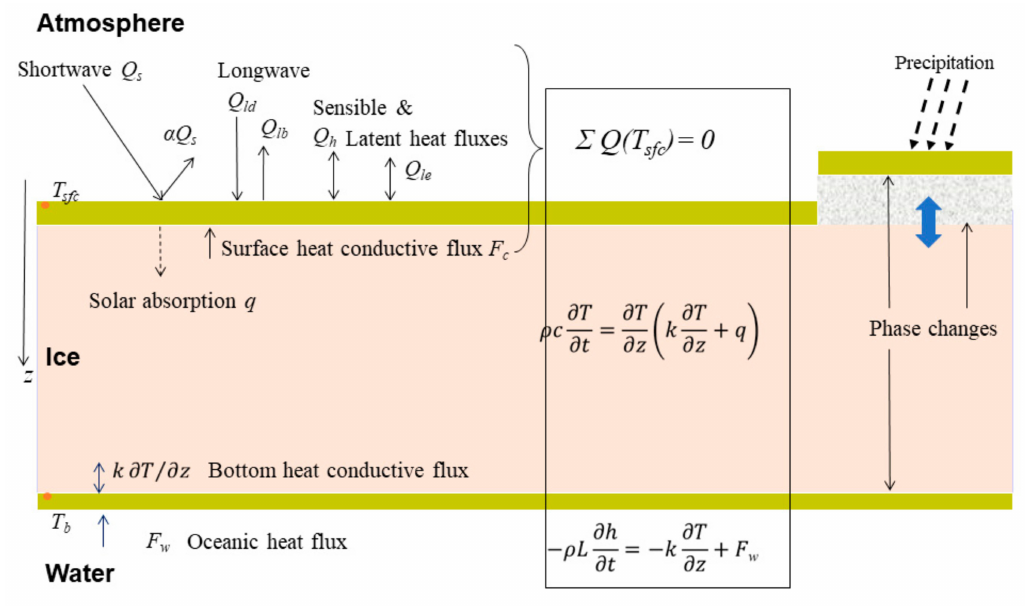
Figure 3. A schematic illustration of the HIGHTSI model [18–20] and various physical processes taken into account in the